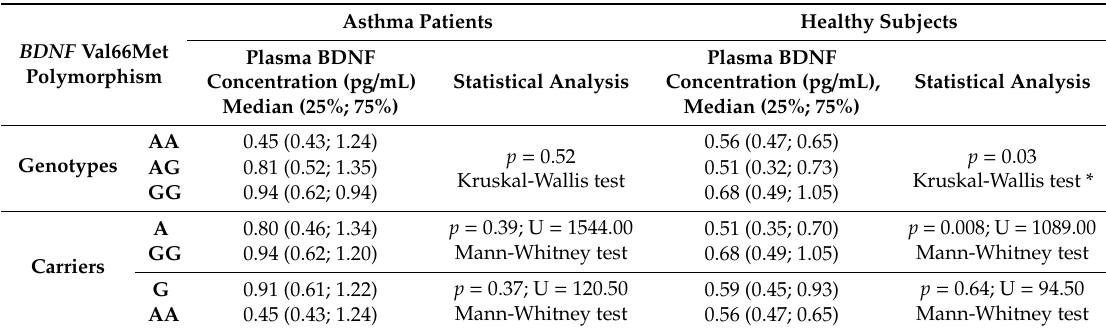
Table 3. Plasma BDNF concentration in asthma patients and healthy subjects carrying di ff erent BDNF Val66Met genotypes and alleles.